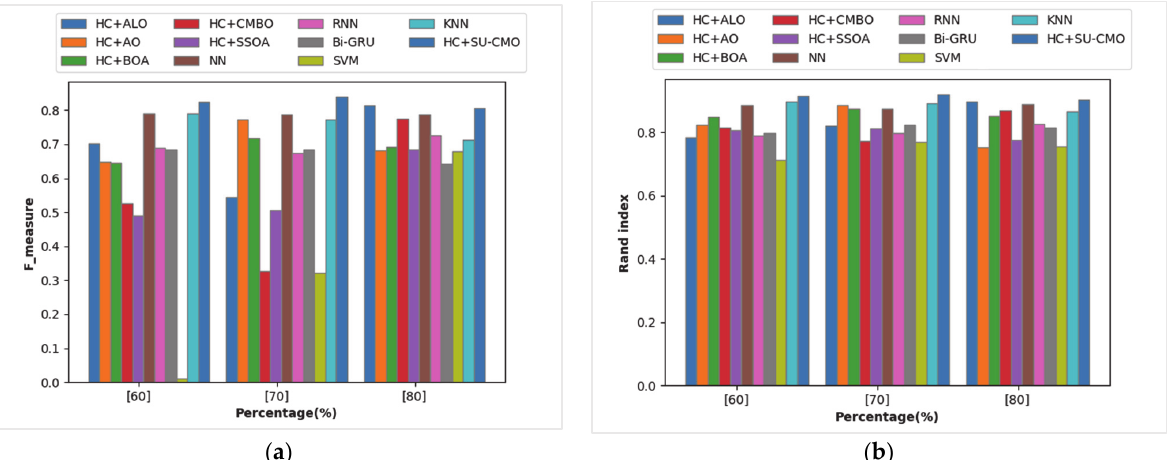
Figure 6. Performance of the adopted model over other existing schemes for dataset 2 ( a ) F-measure ( b ) Rand Index.